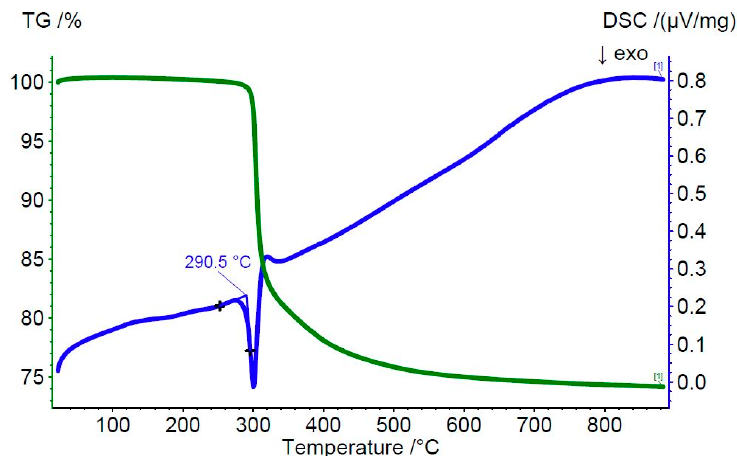
Figure 3. The Thermogravimetry (TG) (green) and Differential Scanning Calorimetry (DSC) (blue) signals from thermal analysis of the as-received carbon fiber reinforced polymer (CFRP) sample showing an exothermic reaction accompanied by mass loss at 290.5 °C.